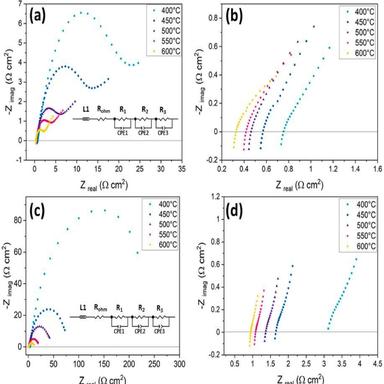
Electrochemical performance and Nyquist plots of (a) Inkjet-printed symmetric cells, (b) high-frequency impedance spectra of inkjet-printed symmetric cells, (c) drop-cast symmetric cells, and (d) high-frequency impedance spectra of drop-cast symmetric cells.